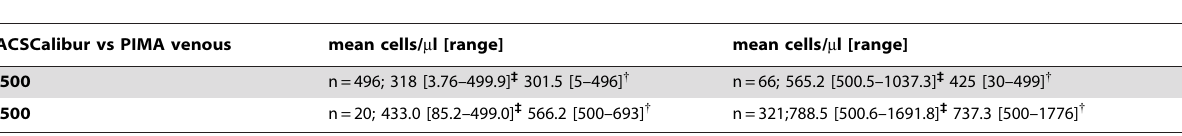
Table 7. CD4 Ranges by Instrument used at 500 cells/ m l*.